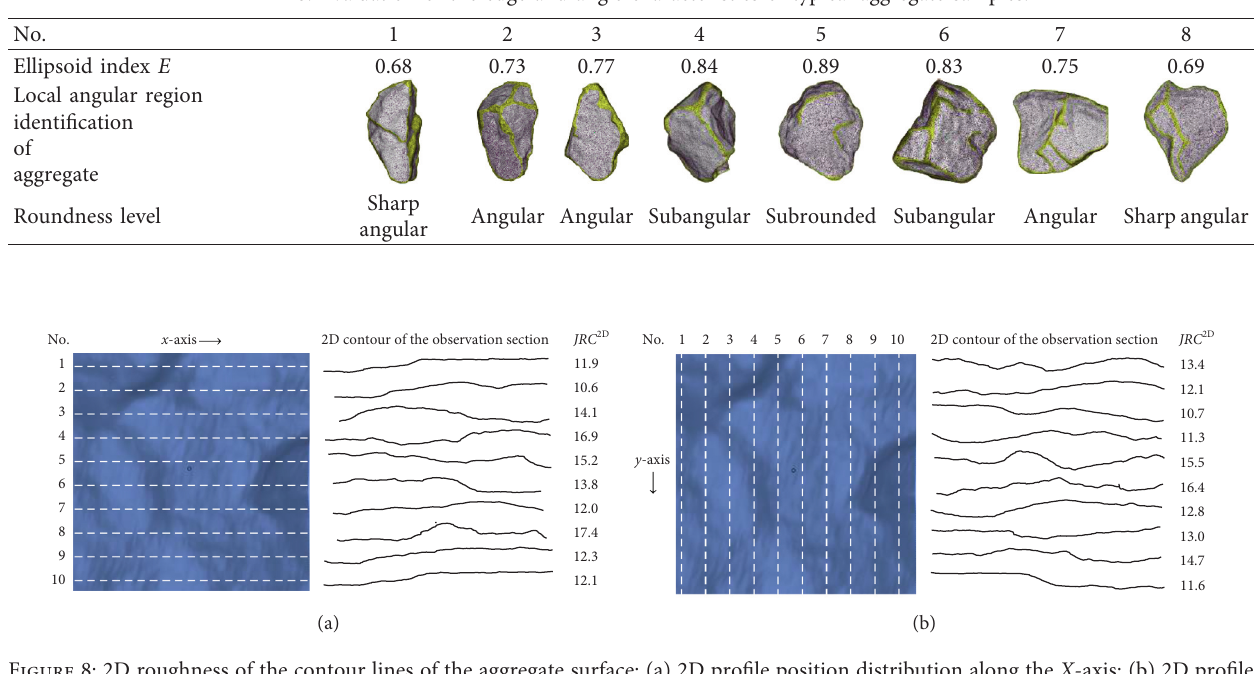
Table 8: Evaluation of the edge and angle characteristics of typical aggregate samples.